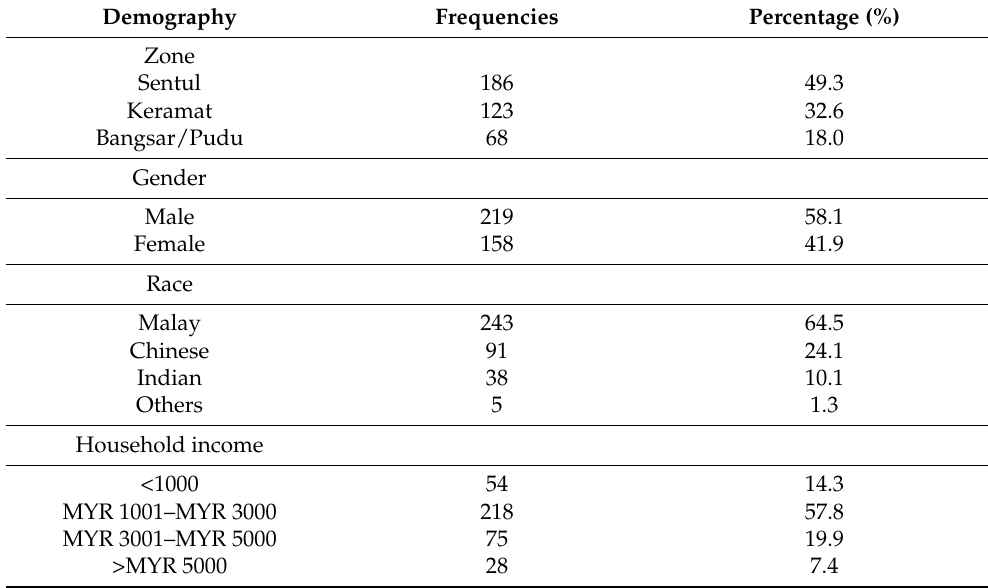
Table 1. Descriptive statistic (n =